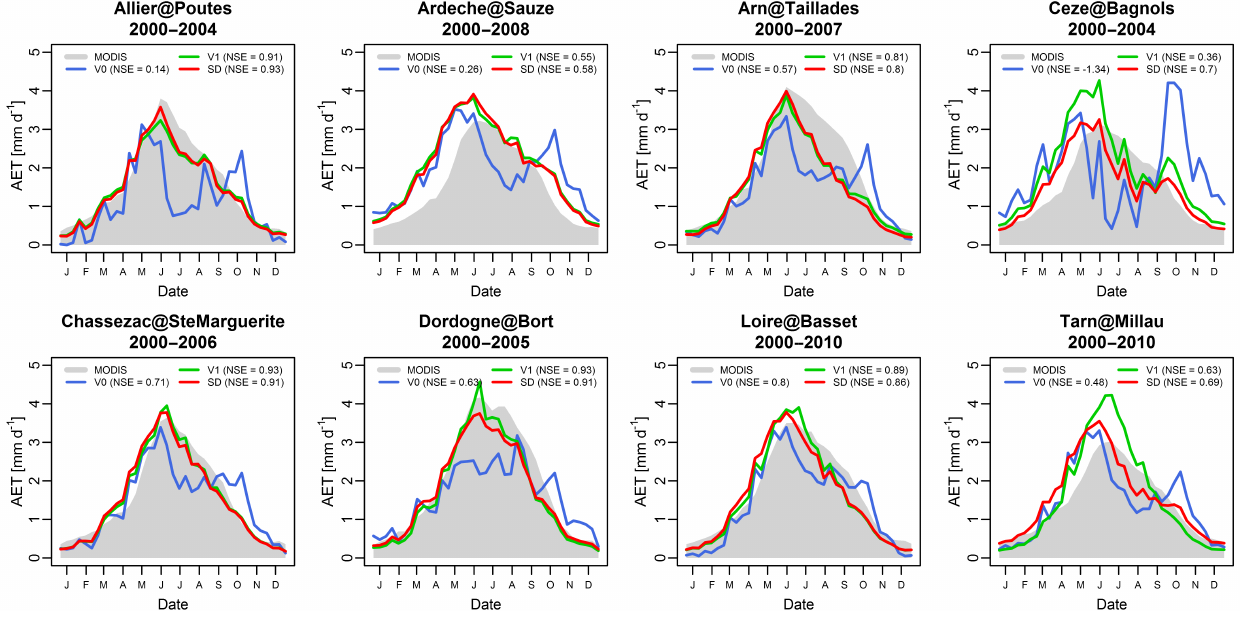
Figure 8. Actual evapotranspiration regime on eight pluvial catchments. Comparison of MOD16 AET product with the three model versions. For each catchment, the considered period is given. NSE values are calculated on AET